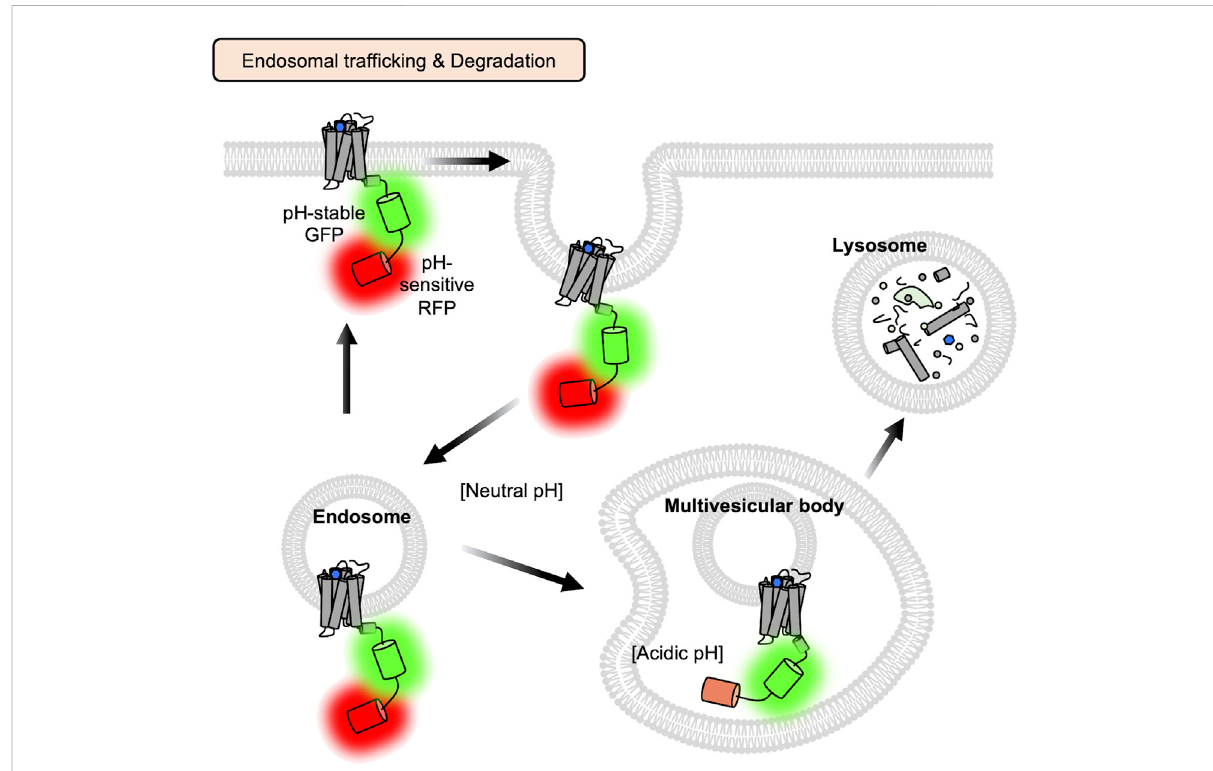
FIGURE 4 Monitoring endosomal traf fi cking and degradation process of GPCRs with the GPCR-pH sensor. To con fi rm that GPCRs encounter the more acidic environment during the endosomal traf fi cking and degradation process (Marchese et al., 2008; Kim et al., 2021a), a GPCR-pH sensor is designed,whichiscomposedof β 2AR,apH-sensitiveFP(Bizzarrietal.,2009;Shenetal.,2014)andapH-stablereferenceFP,whichcancon fi rmthat GPCRs encounter acidic environment during endosomal traf fi cking pathways. Acidi fi cation in the endosomes and lysosomes decreases the fl uorescent intensity of the pH-sensitive RFP, but not the reference FP, thus the acidic state of GPCRs can be predicted by the intensity ratios of pH sensitive-FP (red) and reference FP